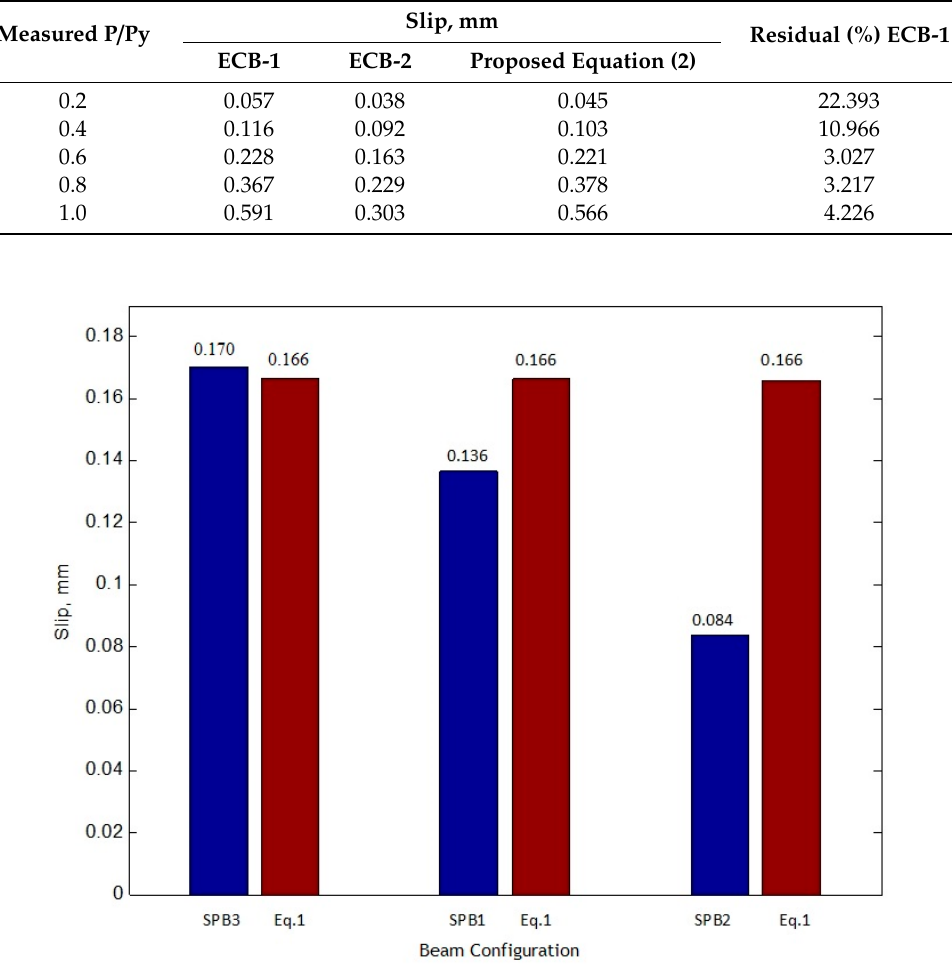
Figure 8. Comparison of proposed Equation (1) with SPB1, SPB2, and SPB3.